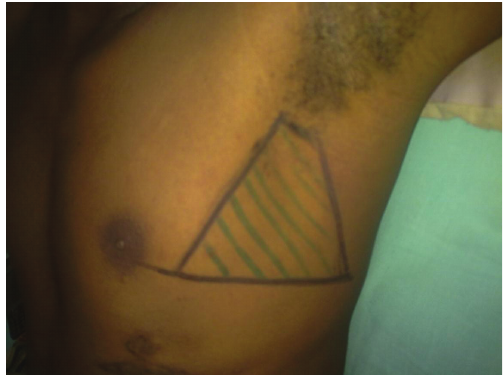
Figure 1: Anatomy of intercostal space.